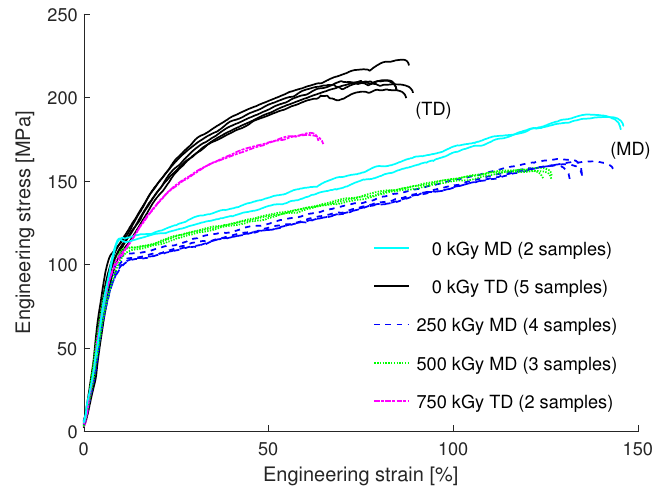
Figure 8. Results of the tensile experiments of the PET foils exposed to different irradiation doses. The number of tested samples for each irradiation dose is indicated. A reduction of the UTS was found for both, the machine and the transverse direction for all irradiation doses. For a dose of 750 kGy the maximum strain exhibited a significant reduction for the TD direction, respectively for the MD direction and 500 kGy. Only a slight reduction was found for the MD direction when irradiated with 250